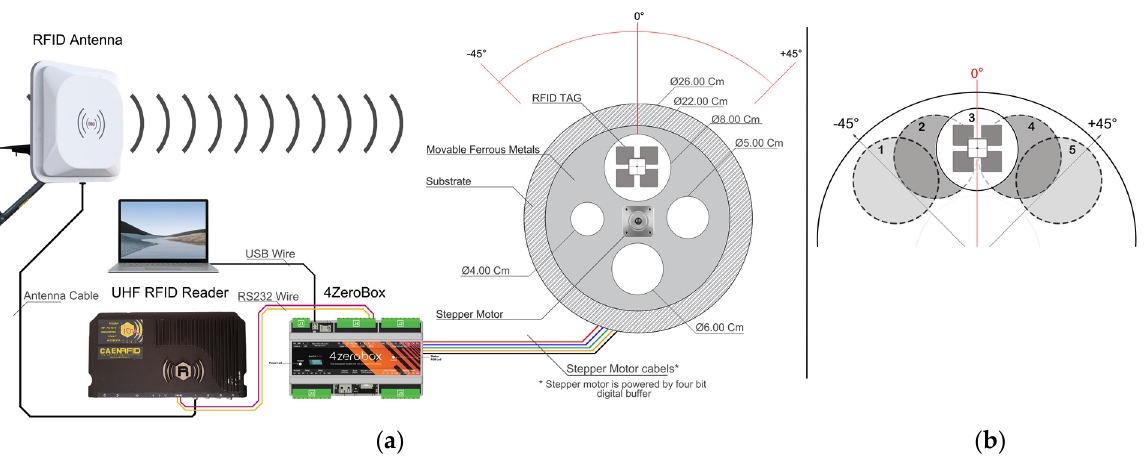
Figure 2. Test bench design and covering proces s .